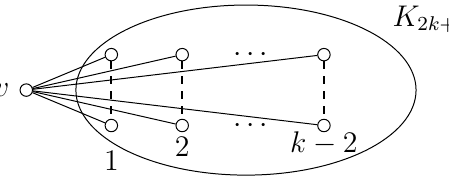
Figure 5: This is the gadget H used to construct a 2 k -regular, 2-edge-connected graph with proper connection number greater than 2 for all k ≥ 3